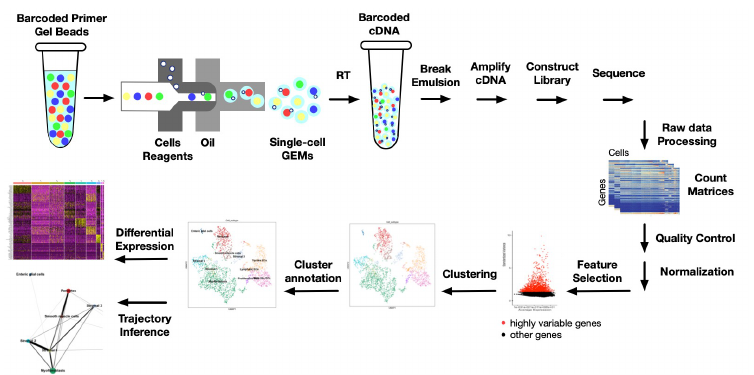
Figure 3. Schematic representation of scRNA sequencing and data analysis